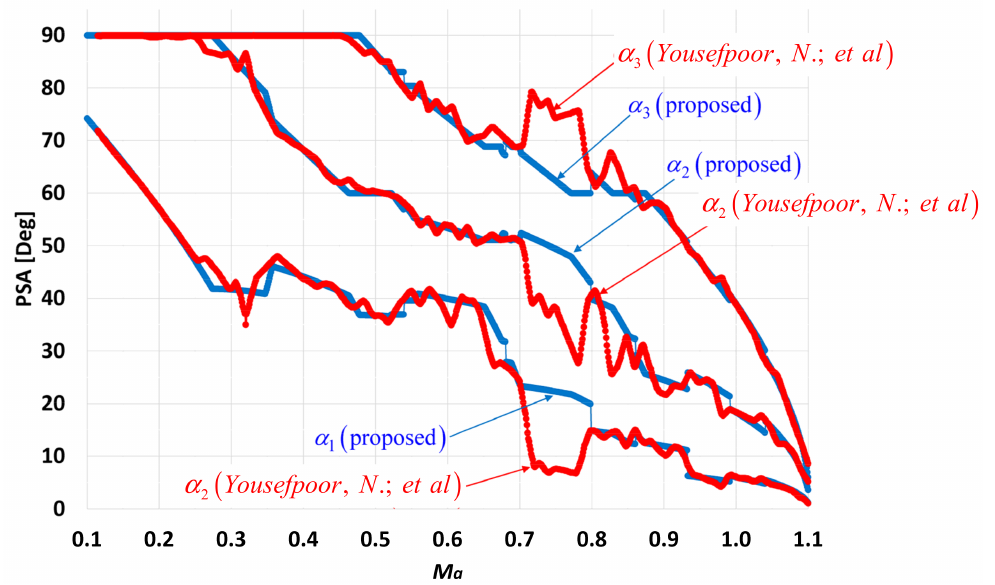
Figure 7. LTHD-optimal PSAs for N = 7: analytical (proposed) vs. obtained from